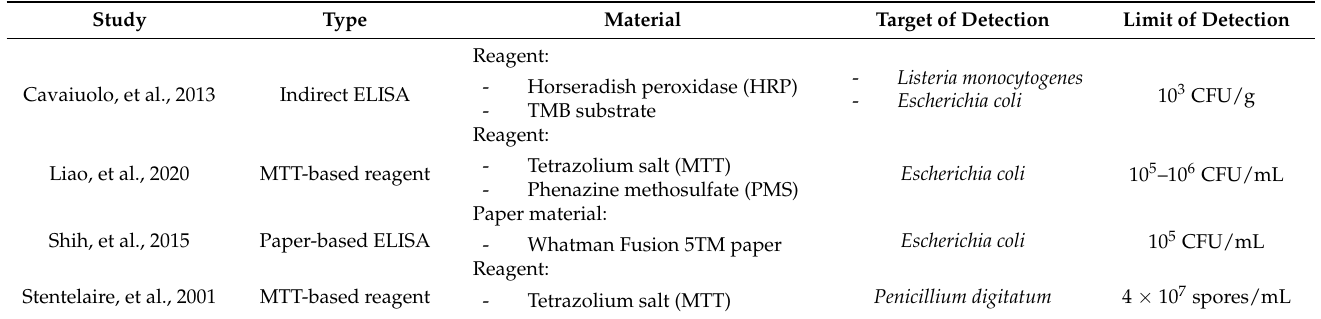
Table 2. A short summary of studies utilizing biochemical analytical tools for the detection of